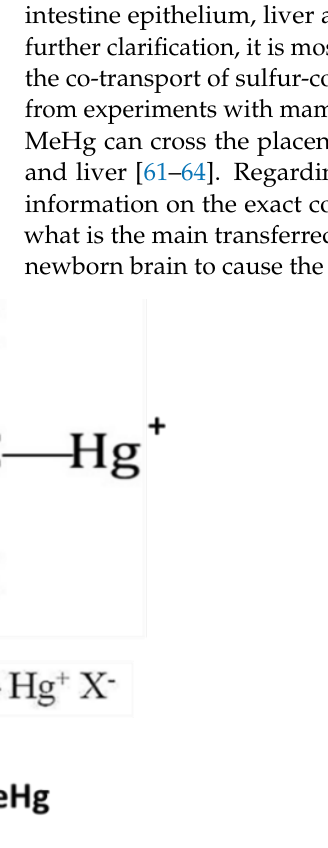
Figure 1. Chemical structures of methylmercury (MeHg) and ethylmercury (EtHg).